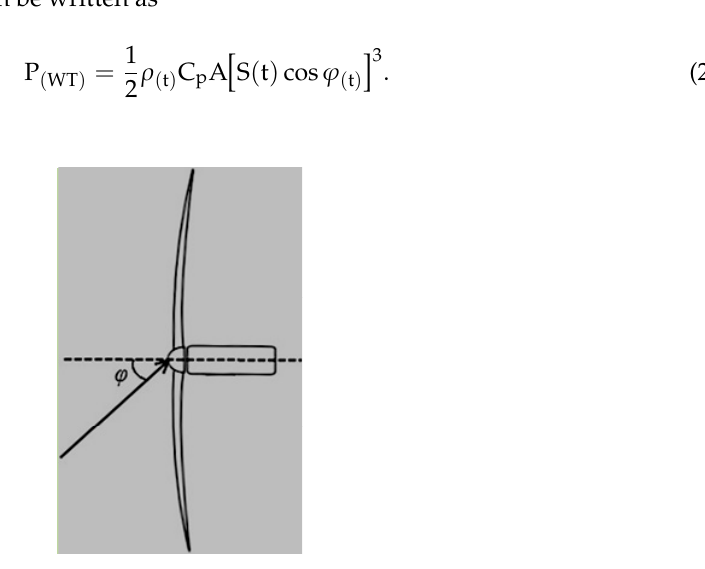
Figure 2. Wind hitting the rotor at an angle φ in the horizontal plane.